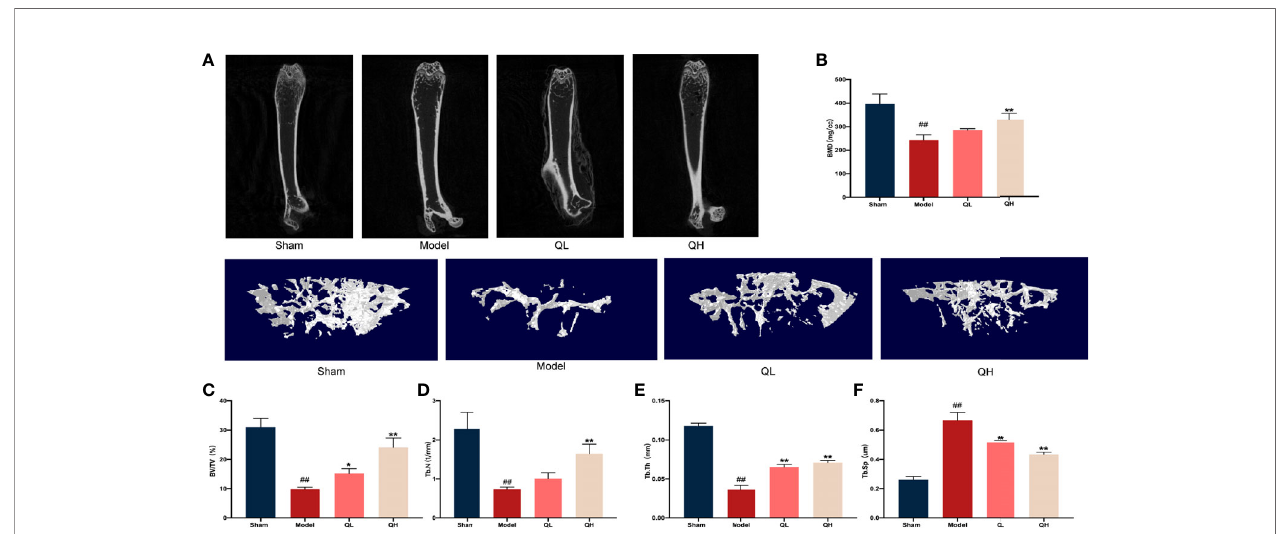
FIGURE 2 | Quercetin induced improvement of bone microstructure in mice that underwent orchiectomy. (A) 2D images and 3D reconstruction of the distal femur by micro-computed tomography. (B) Bone mineral density ( BMD) of the distal femur. (C – F) Changes in bone characteristics, including bone volume/tissue volume (BV/TV), trabecular number (Tb. N), trabecular thickness (Tb. Th), and trabecular separation (Tb.Sp). ## p< 0.01 vs. sham group; * p< 0.05, ** p< 0.01 vs. model group.